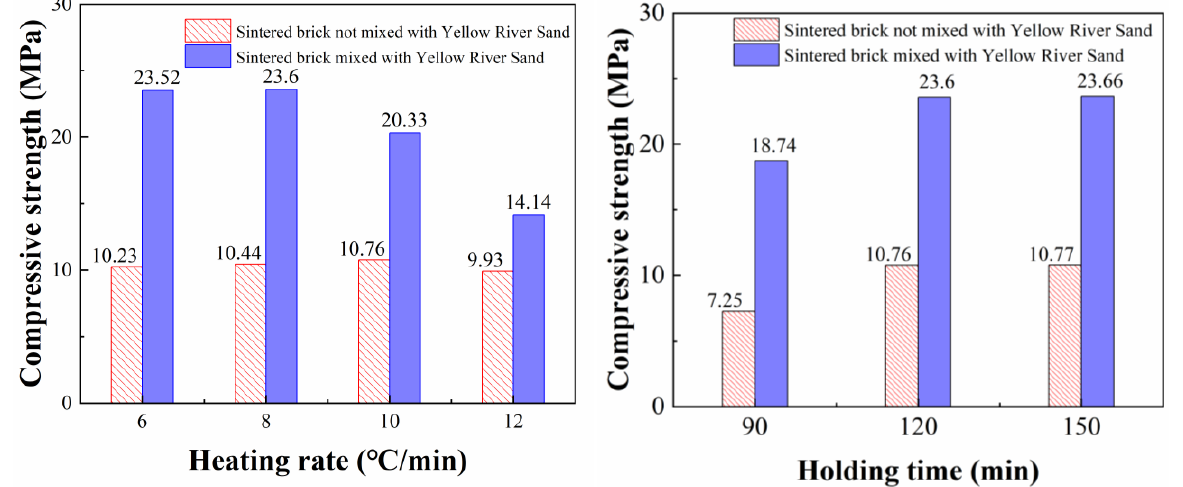
Figure 5. Effect of heating rate and holding time on compressive strength of MGS sintered